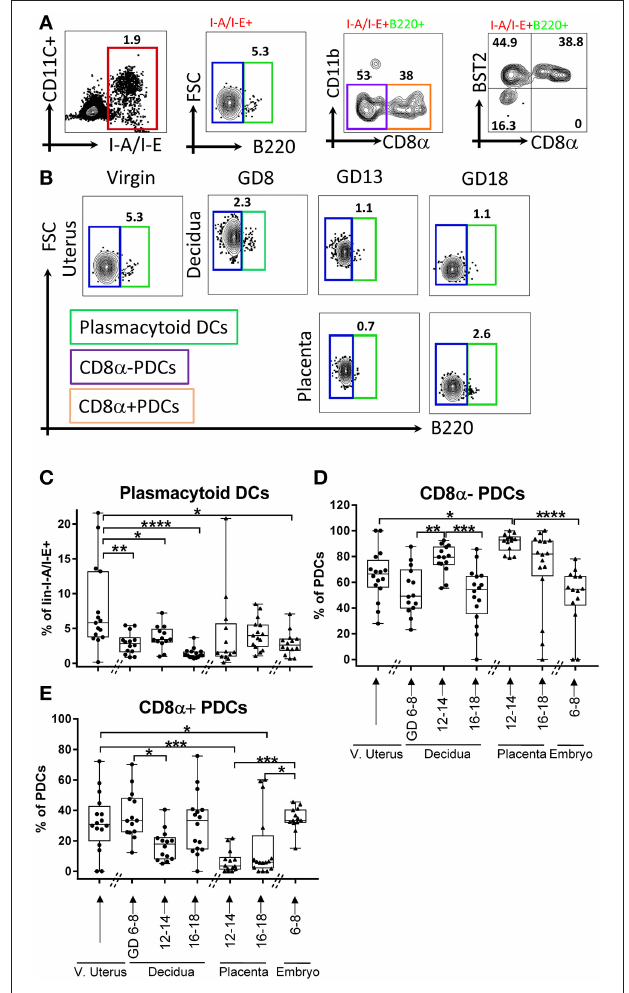
FIGURE 2 | Flow cytometry gating strategy and dynamics of plasmacytoid dendritic cells (PDCs) in the murine uterus, decidua, placenta, and embryo. (A) PDCs, defined as live and lineage negative (CD3 neg NK1.1 neg CD19 neg L-Y-6G neg ) I-A/I-E + B220 + , and its subsets CD8 α + /– PDCs, were identified in the murine decidua. (B) Gating of lin1-I-A/I-E + B220 + /– in murine virgin uterus, decidua, placenta, and embryo across the gestational age, upper panel showed decidua, lower panel showed as placenta. (C) Proportions of PDCs out of lin1-I-A/I-E + in murine virgin uterus, decidua placenta, and embryo across gestational age. (D) Proportions of CD8 α -PDCs out of PDCs in murine virgin uterus, decidua, placenta and embryo across gestational age. (E) Proportions of CD8 α + PDCs out of PDCs in murine virgin uterus, decidua, placenta, and embryo across gestational age. n = 13–16 (16 independent experiments), the exact number of animals was summarized in Supplementary Table 3 . The data of virgin uterus were compared